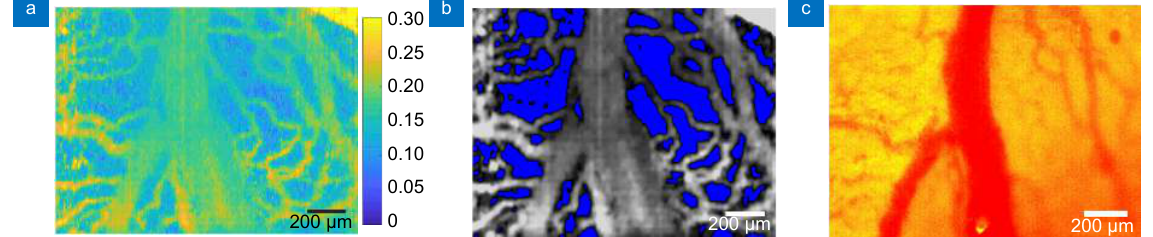
Fig. 4 | Morphological information from the β map. ( a ) An averaged β map obtained from a chick embryo (No. 4). ( b ) The contrast-enhanced version of (a). ( c ) A wide-field color image of the vasculature in the same FOV with white light